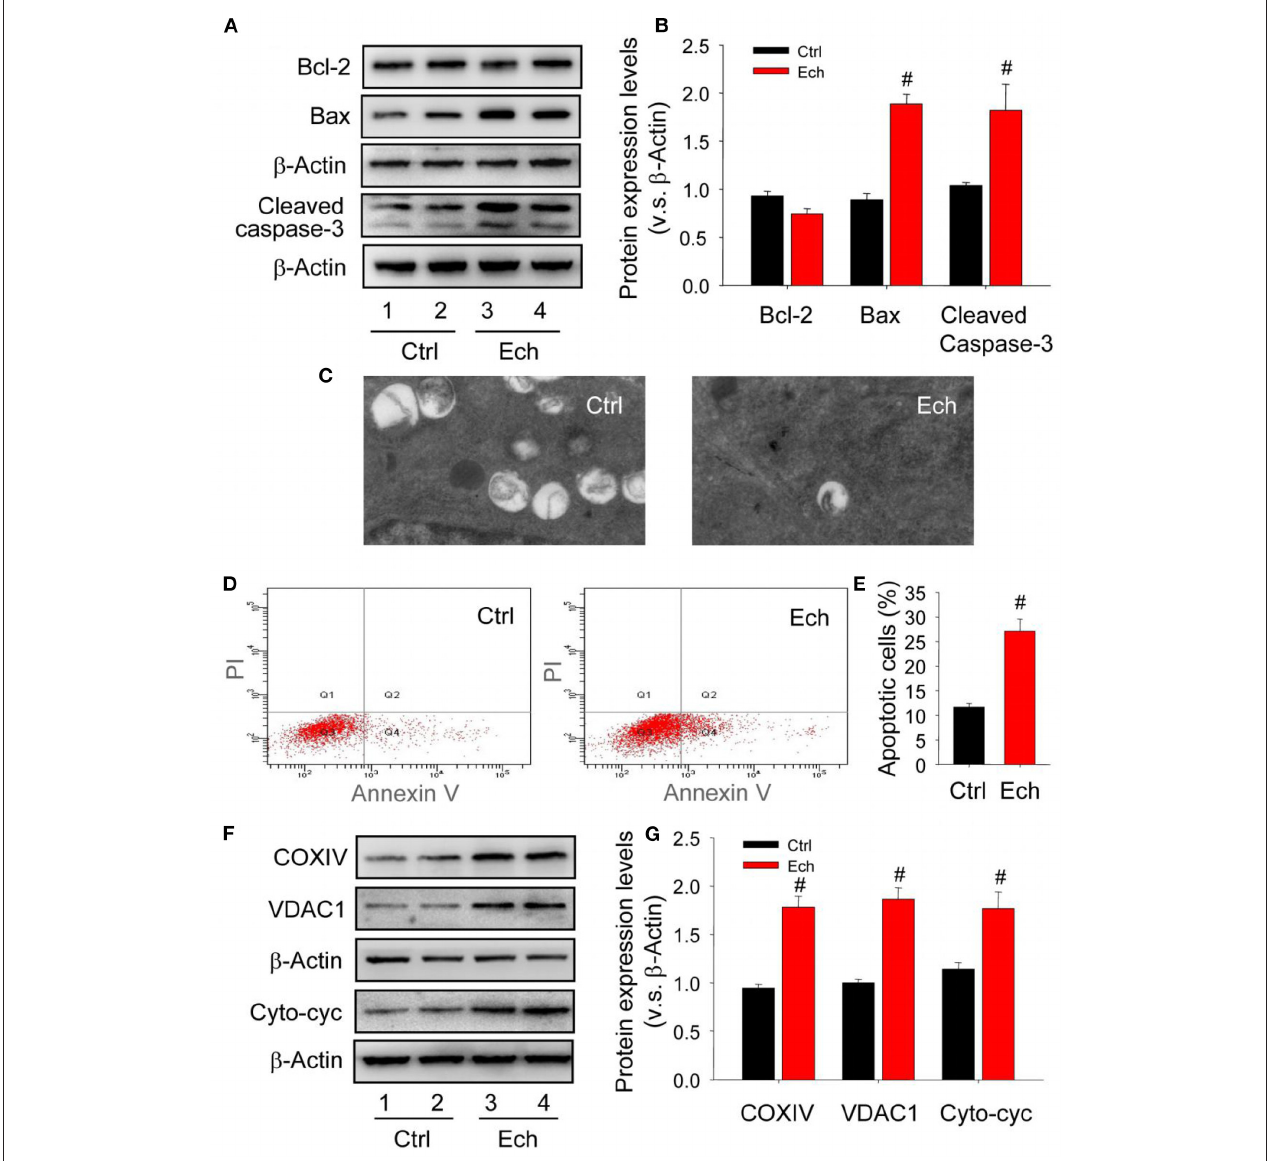
FIGURE 12 | Mitochondrial impairment contributes to the apoptosis during the formation of corpus luteum. (A) Expression changes of Bcl-2, Bax, and cleaved caspase-3 during the formation of corpus luteum after echinomycin treatment. (B) Summarized intensities of Bcl-2, Bax, and cleaved caspase-3 blotting normalized to the control. (C) TEM images of the autophagosome in luteal cells with or without echinomycin treatment. (D) Representative images of Annexin V-PI staining in luteal cells obtained from pregnant ovary with or without echinomycin treatment. (E) Quantitative analysis of luteal cell apoptosis by flow cytometry during the formation of corpus luteum with or without echinomycin treatment. (F) Expression changes of VDAC1, COXIV, and cytoplasmic cytochrome c in luteal cells during the formation of corpus luteum (Day 1) with or without echinomycin treatment. (G) Summarized intensities of VDAC1, COXIV, and cytoplasmic cytochrome c bloting normalized to the control. Each value represents the mean ± SE. One-way analysis of variance (ANOVA) was used to analyze the data, followed by a Tukey’s multiple range test. n = 6. Ctrl, control; Cyto-cyc, cytoplasmic cytochrome c, # P < 0.05, vs. the group in